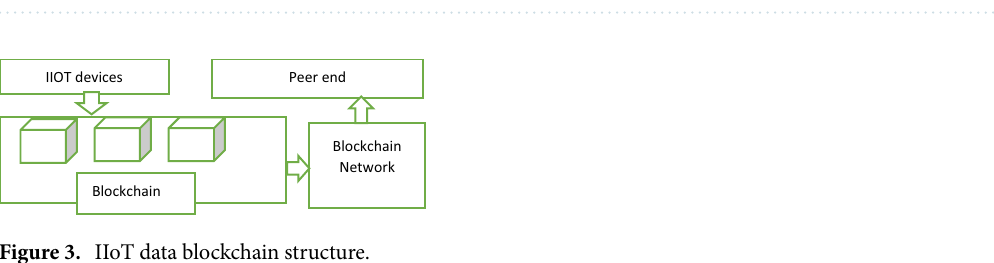
Figure 2. Basic data blockchain structure.